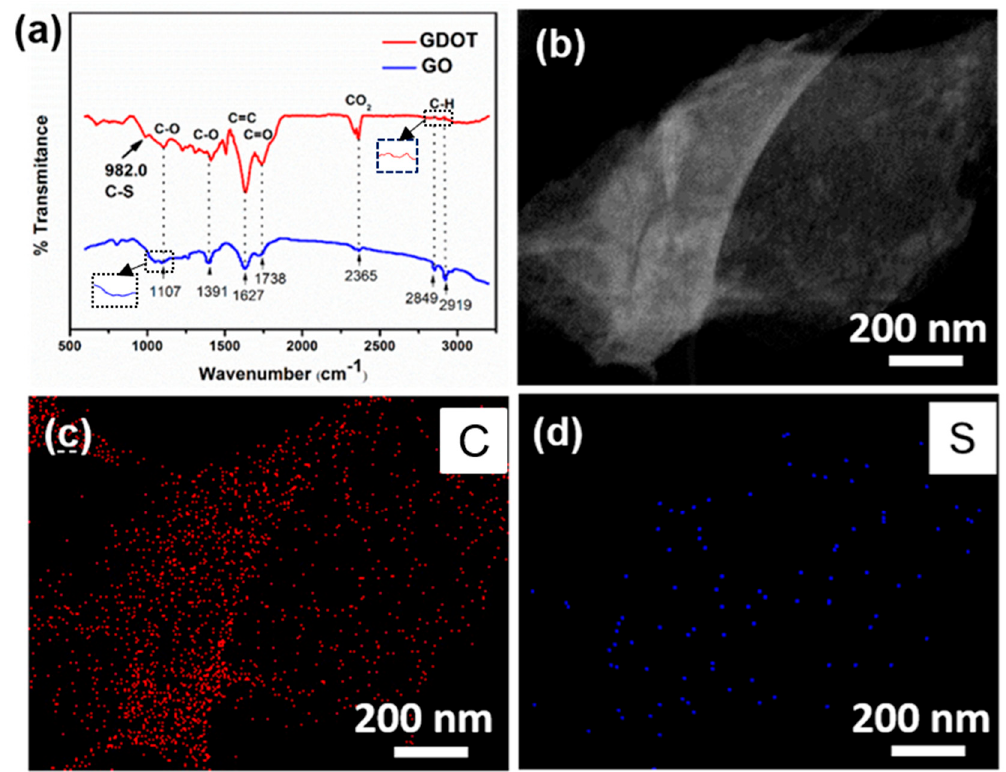
Figure 5. ( a ) FTIR measurements of GDOT and GO; ( b ) HAADF-STEM image of GDOT; and ( c , d ) the corresponding element